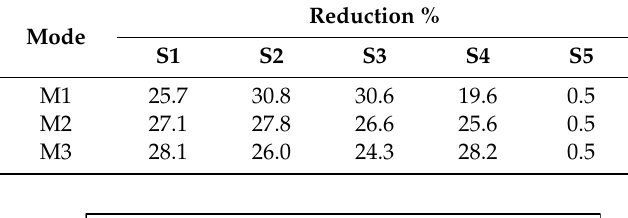
Table 3. The reduction of each stand under di ff erent load distribution mode.